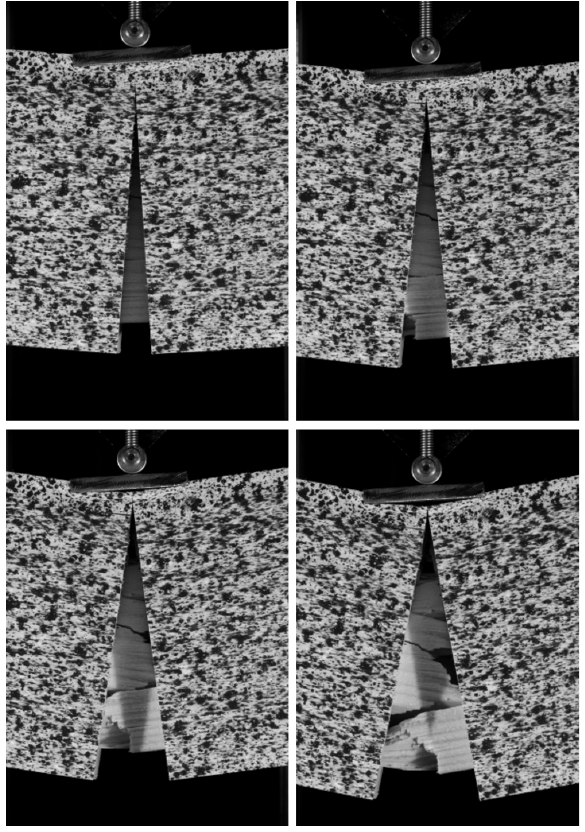
Figure 9. Damage evolution of the beam #01 with the first failure F1 - splinter around the